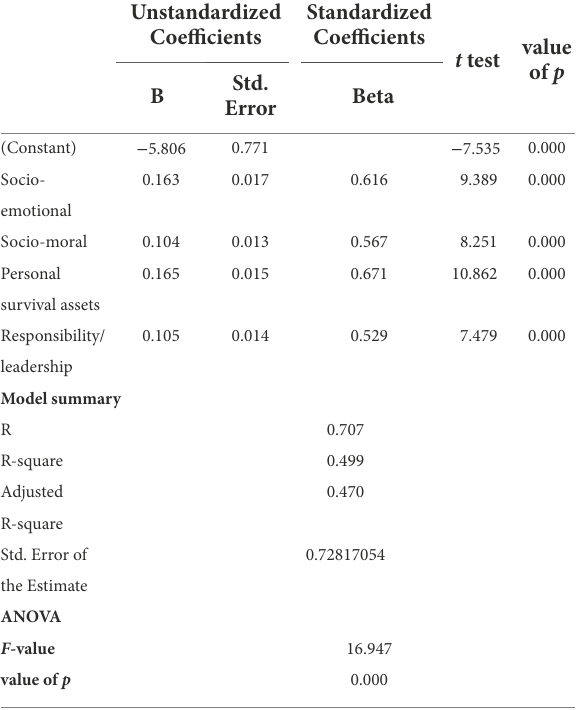
TABLE 3 Regression analysis estimating the effect of resilient cultural practices on cognitive